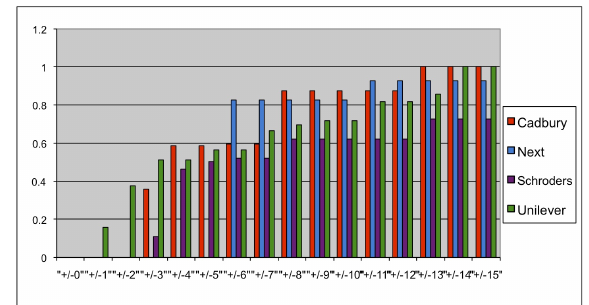
Figure 11 Percentage of EDDIE 8’s indicators that are close to EDDIE 7’s vocabulary, for the stocks that ED 8 Fit < ED 7 Fit . This percentage can be viewed in the y-axis. The x-axis presents the number of days that an EDDIE 8’s in- dicator is away from the pre-specified indicators of EDDIE 7